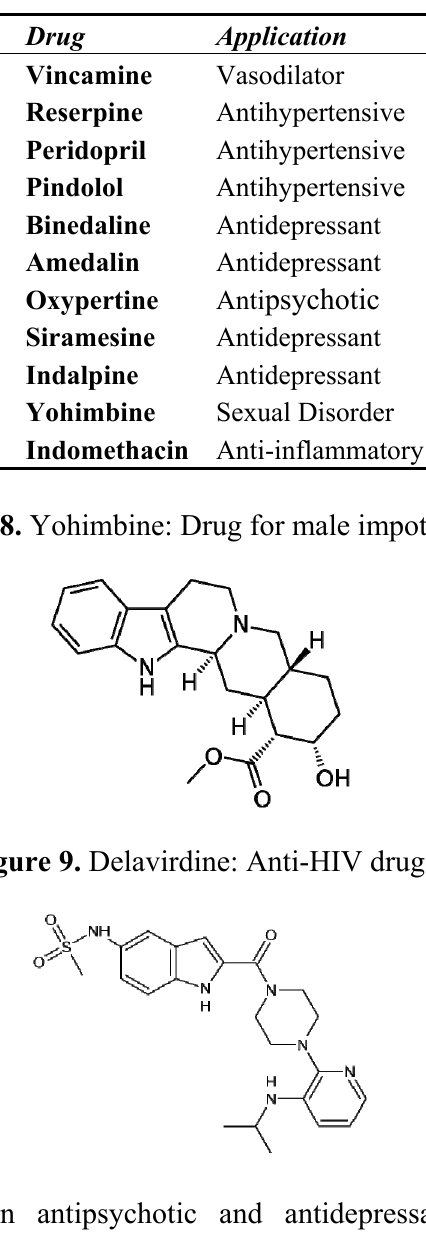
Table 1. Indole ring containing drug molecules.